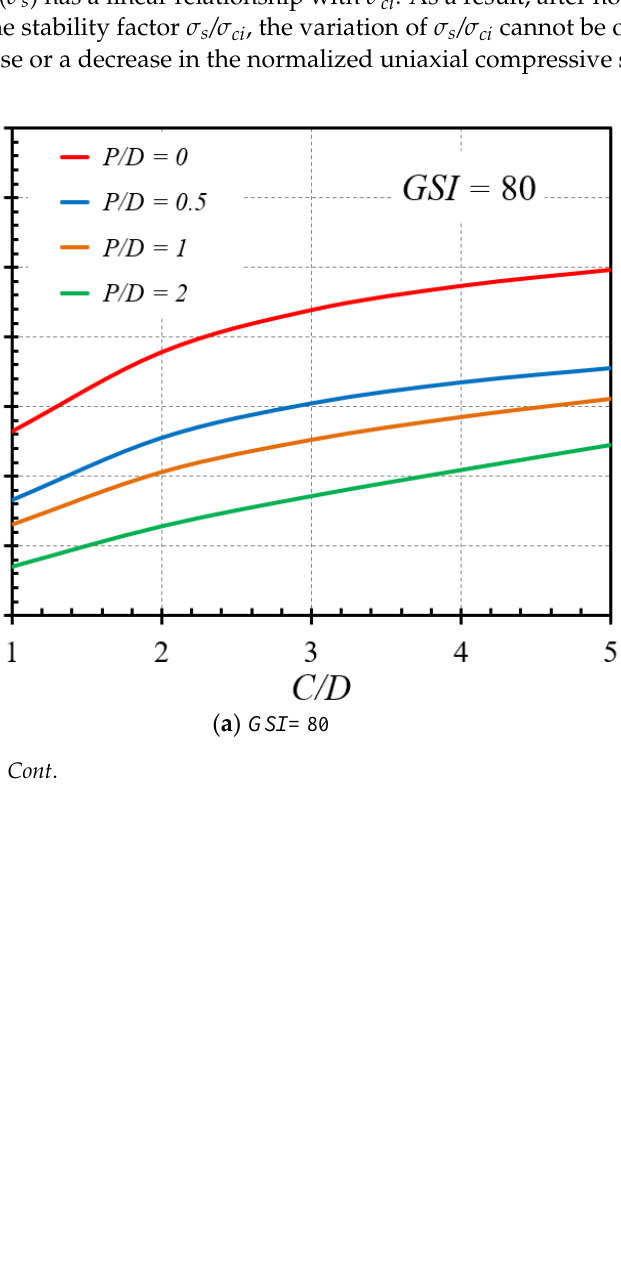
Figure 10. Impact of P/D on the stability solutions of tunnel headings ( γ D/ σ ci = 0 and m i = 5).